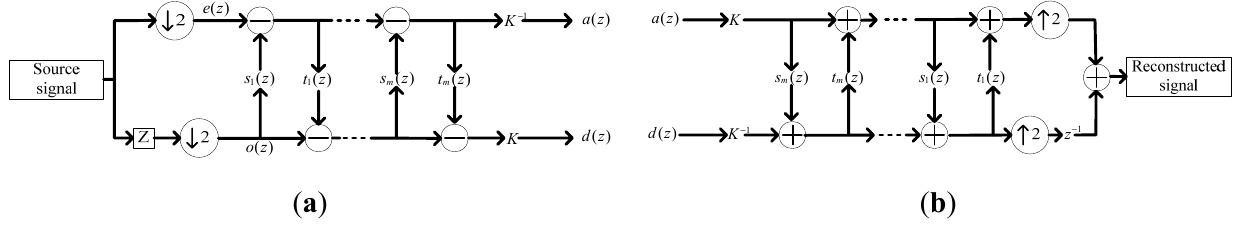
Figure 2. The polyphase-based wavelet transform in lifting scheme. ( a ) The wavelet analysis process. ( b ) The wavelet reconstruction process.